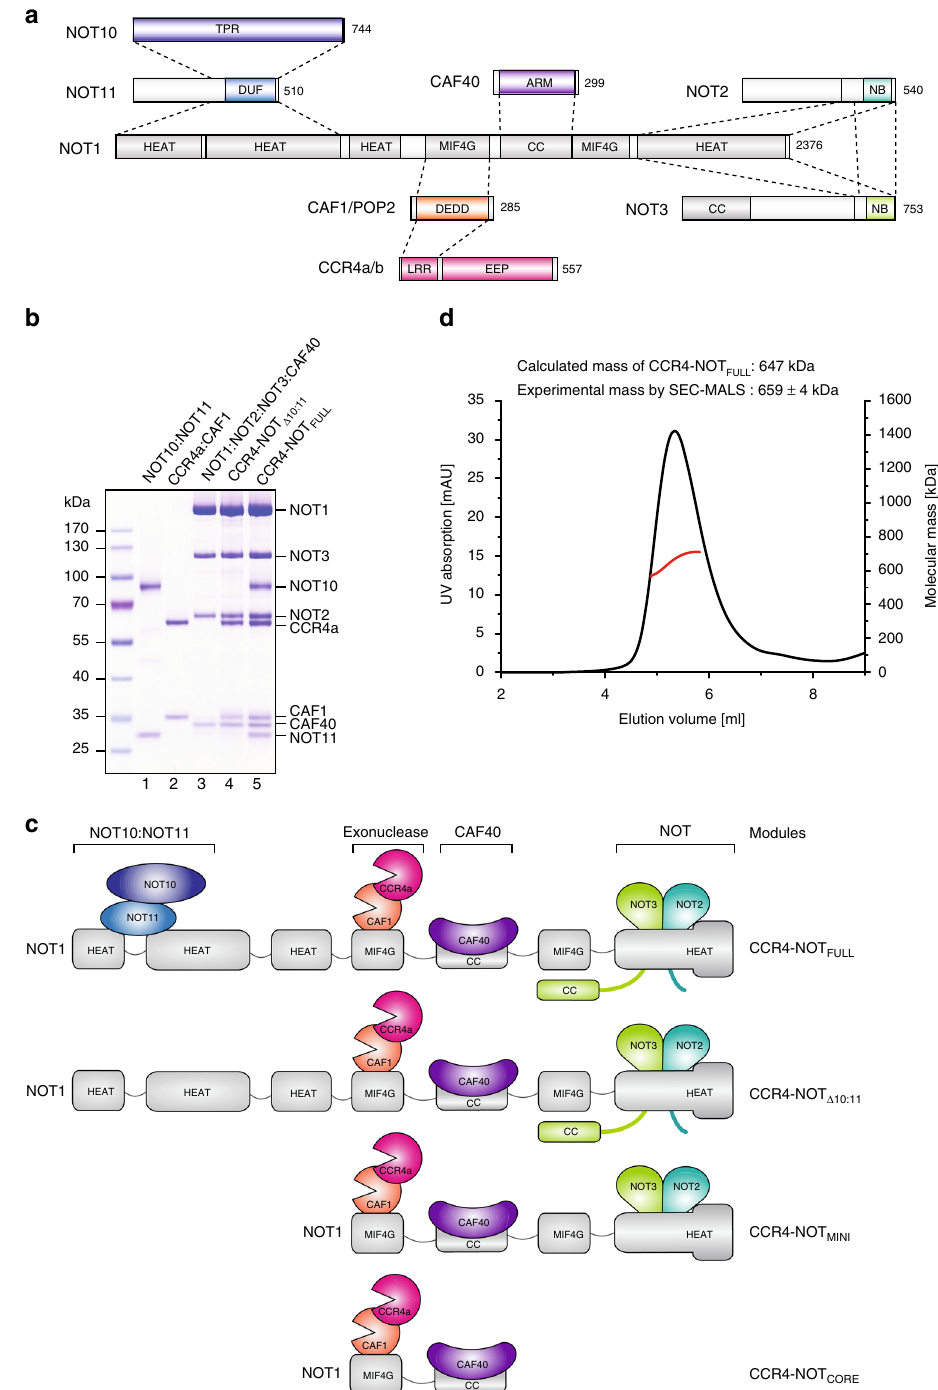
Fig. 1 Architecture and reconstitution of the human CCR4-NOT complex. a Schematic representation of the human CCR4-NOT complex. Domains are indicated and known interactions between domains are shown by dashed lines. HEAT: domain consisting of α -helical HEAT-like repeats; MIF4G: HEAT-like domain with structural similarity to the middle domain of eIF4G; DUF: domain of unknown function 2363; TPR: predicted domain consisting of α -helical TPR-like repeats; ARM: domain consisting of α -helical armadillo repeats; EEP: endonuclease/exonuclease/phosphatase family member; LRR: Leucine-rich repeats; DEDD: exonuclease of the DEDD family; CC: predicted coiled-coil domain; NB NOT-box domain. b Coomassie-stained gel with the puri fi ed recombinant NOT10:NOT11, CCR4a:CAF1 and NOT1:NOT2:NOT3:CAF40 complexes used for modular reconstitution, and the resulting assembled CCR4- NOT Δ 10:11 and CCR4-NOT FULL complexes. Source data are provided as a Source Data fi le. c Schematic representation of the reconstituted complexes used